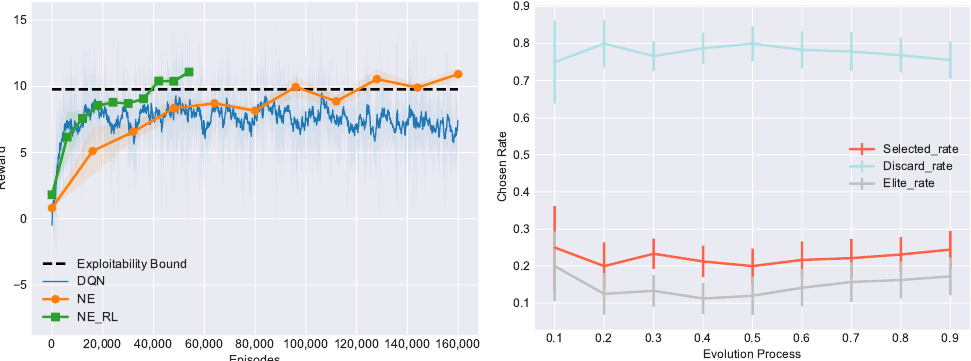
Figure 4. ( Left ) Comparative performance of NE_RL, NE, and DQN in training against the RA opponent. ( Right ) Average selection rate of the transferred RL agents changes during the course of evolution and plot with error